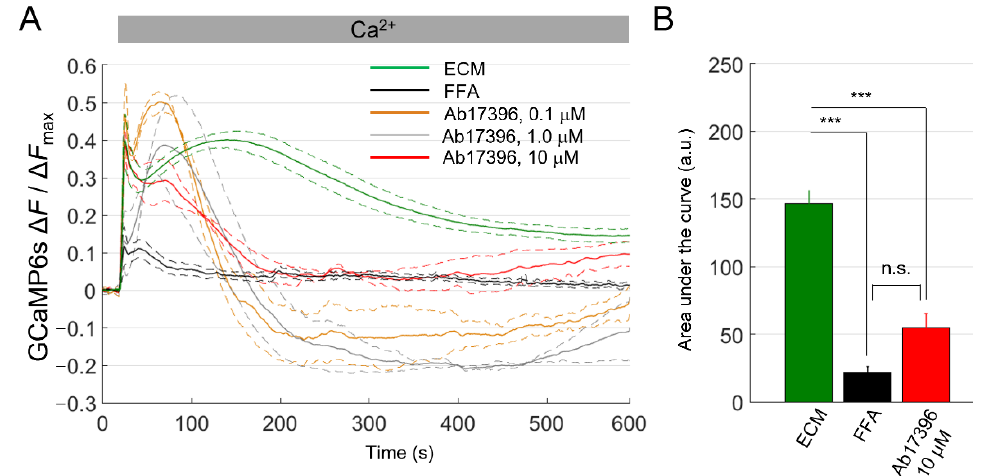
Figure 6. Ca 2+ uptake assay in HaCaT-Cx46-GCaMP6s cells. ( A ) The mean normalized Ca 2+ uptake traces (solid lines) ± s.e.m. (dashed lines) obtained from HaCaT-Cx46-GCaMP6s in ECM (green, n = 5), ECM plus FFA (100 µ M, black, n = 6), ECM plus 0.1 µ M anti-Cx46 mAb Ab17396 (orange, n = 3), ECM plus 1 µ M Ab17396 (gray, n = 3) or ECM plus 10 µ M Ab17396 (red, n = 3). ( B ) Areas subtended by normalized Ca 2+ uptake traces (mean ± s.e.m.) in the time interval between t = 20 s and t = 590 s for some of the data shown on the left; 0.1 µ M Ab17396 and 1 µ M Ab17396 conditions were omitted due to the negative swing; this was never observed with other inhibitors or in control conditions. Statistical significance was calculated using the Bonferroni post hoc test for pairwise comparisons after the ANOVA test; ***, P < 0.001; n.s. not significant. FFA (100 µ M) strongly reduced Ca 2+ uptake in HaCaT-Cx46-GCaMP6s cells